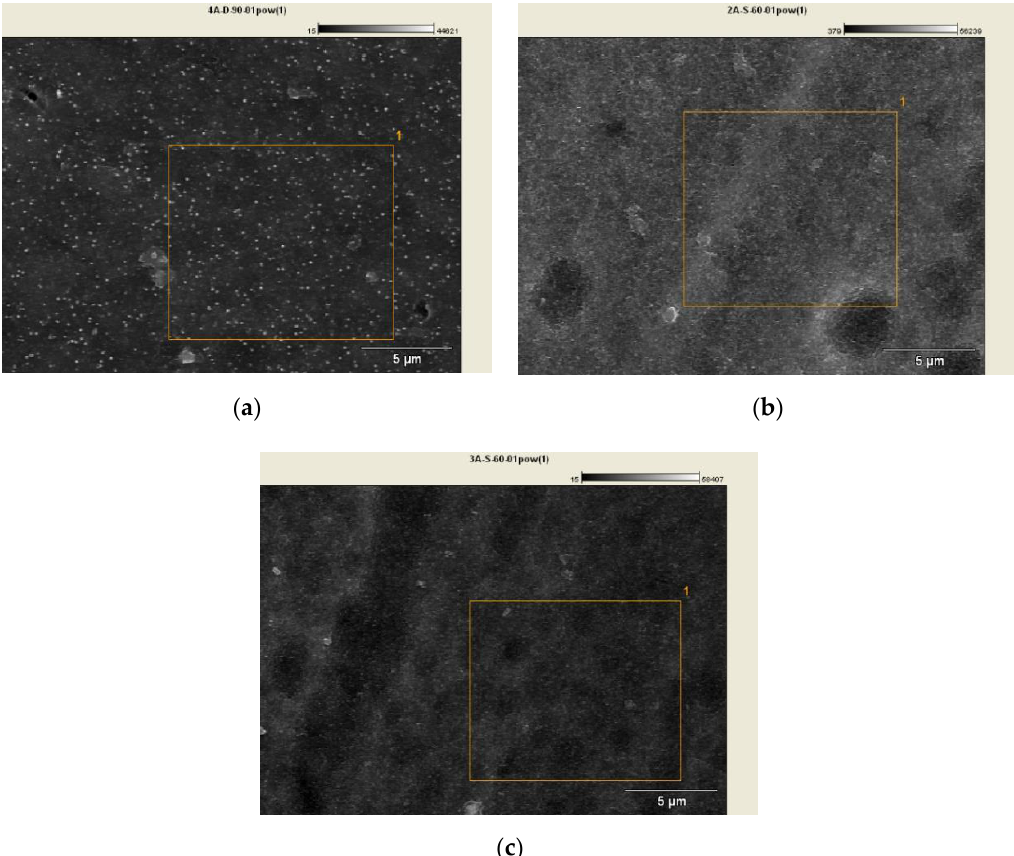
Figure 5. SEM micrographs with chemical analysis field marked: ( a ) Sample 02D, ( b ) Sample 02E, ( c ) Sample 02K.